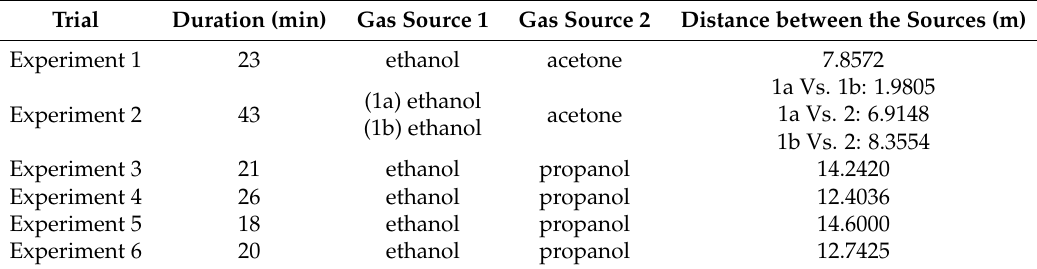
Table 1. Summary of